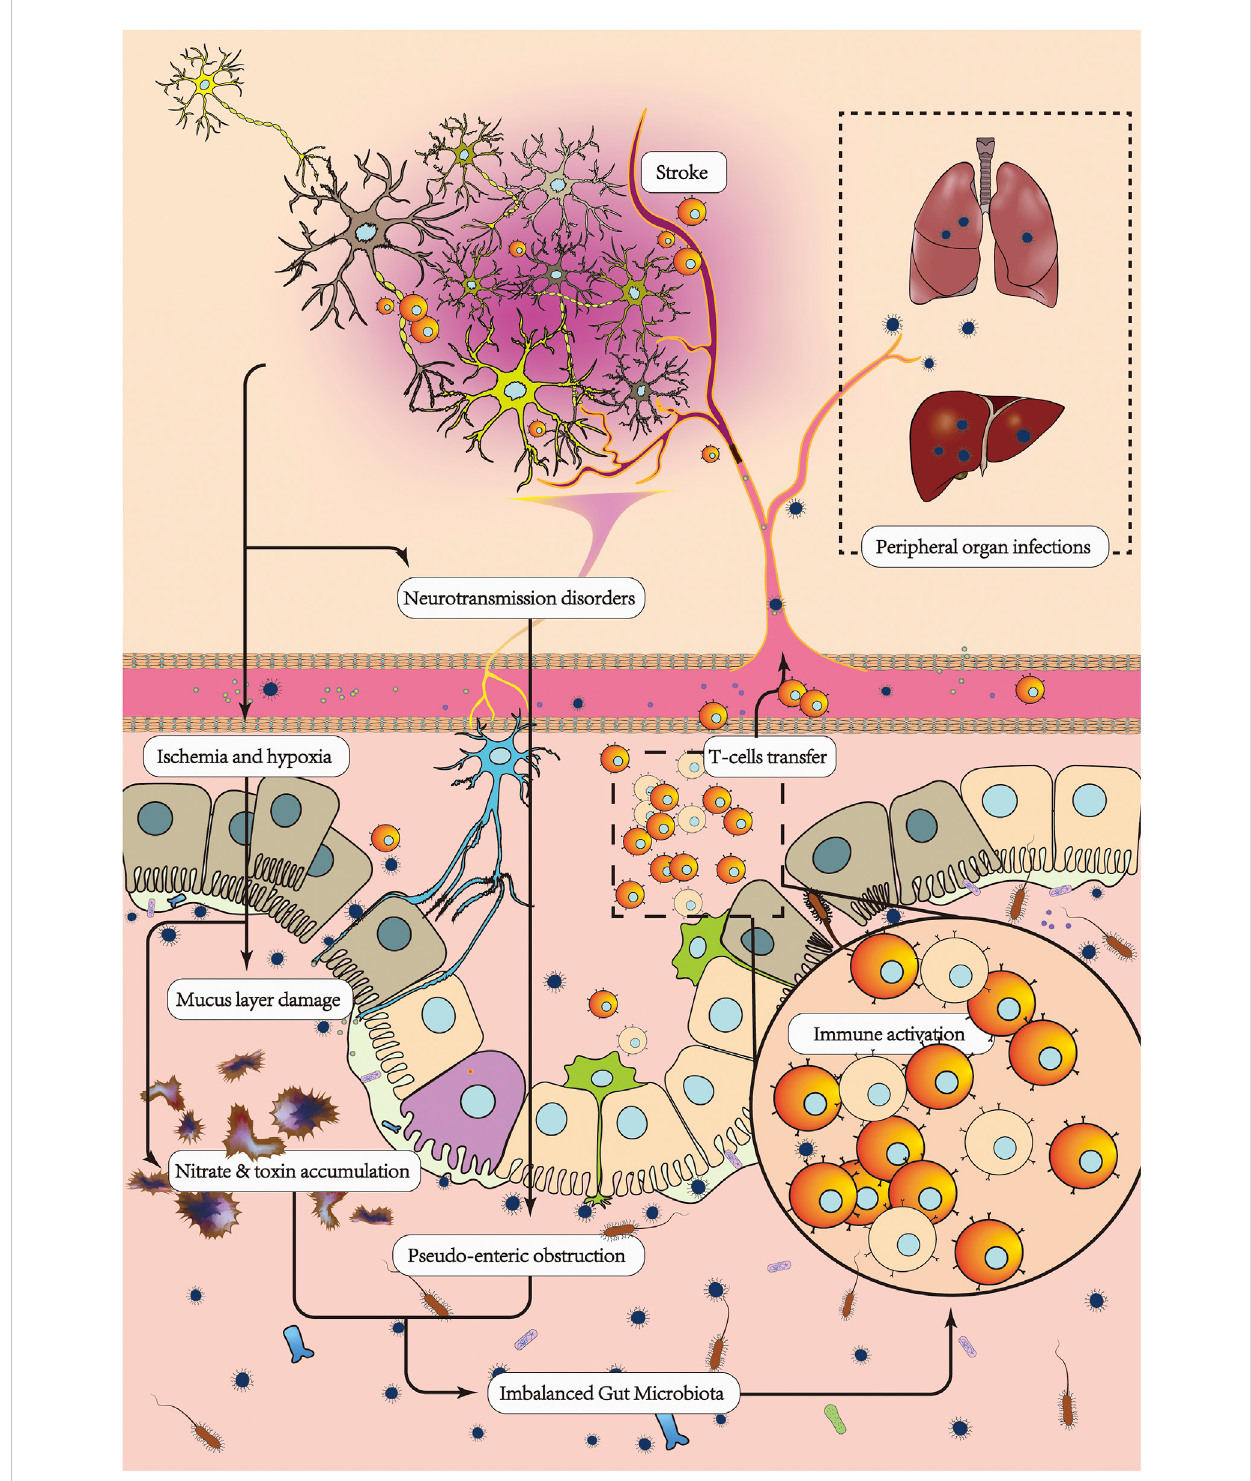
FIGURE 2 After AIS, the brain-gut regulatory mechanism is inhibited, resulting in an imbalance in the intestinal environment, leading to a decrease in probiotic bacteria and an increase in pathogenic bacteria. Enteric nerve conduction disorders cause pseudointestinal obstructionand constipation, whichleadsto afailureofpathogenicbacteriaandharmfulsubstancesintheintestinaltracttobeexcretedinthefecesinatimelymanner.Ontheotherhand,adisturbed gutmicrobiotahasaseriousimpactonAIS.Intestinalimmunehomeostasisisdisrupted,theproin fl ammatory/anti-in fl ammatorylymphocyteratiois imbalanced, and more proin fl ammatory lymphocytes are transferred from the gut to the damaged brain, leading to increased in fl ammatory damage and apoptosis in the brain. Massive loss of probiotic bacteria and thinning of the intestinal mucus layer leads to increased intestinal barrier permeability, makingiteasier forpathogenicbacteria tocross theintestinal walland enterthecirculation, causingperipheral organinfectionsandsepsis. Dysregulated secretionofmetabolitesfromthegutmicrobiota,suchasdecreasedSCFAs,increasedTMAO,increasedLPS,increasedexcitatoryneurotransmitters,and decreased inhibitory neurotransmitters, leads to a poorer prognosis for